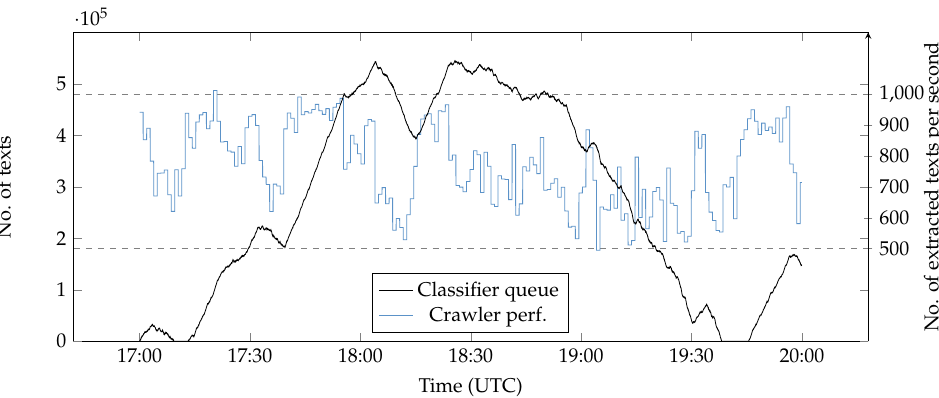
Figure 11. Three-hour experiment (using 3 nodes). The parallelism levels (crawler/classifier) were 170/0, 0/50 and